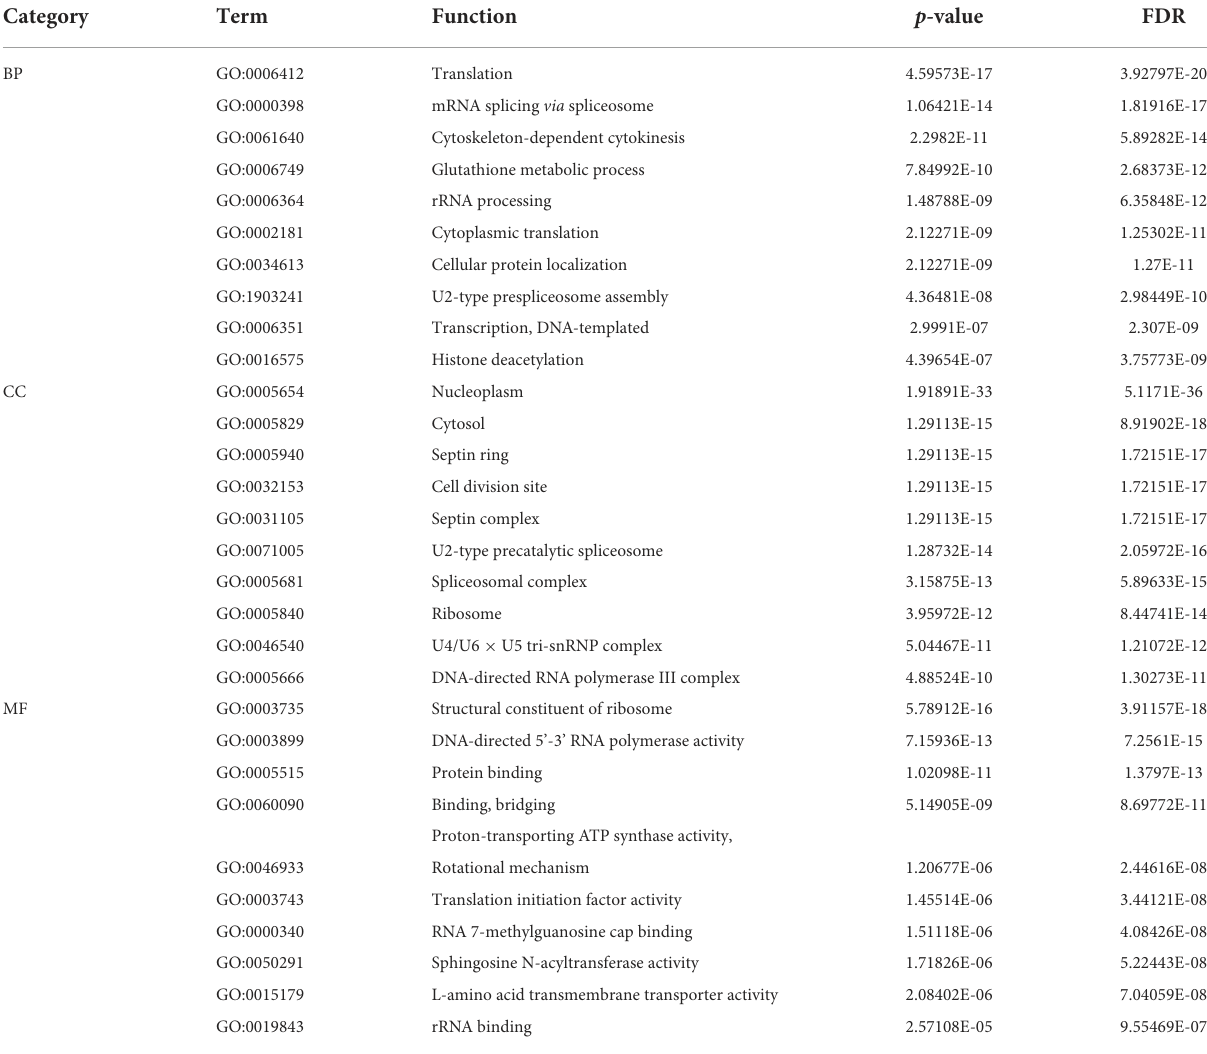
TABLE 4 Ten functional annotations with the largest statistical significance for three branches in GO